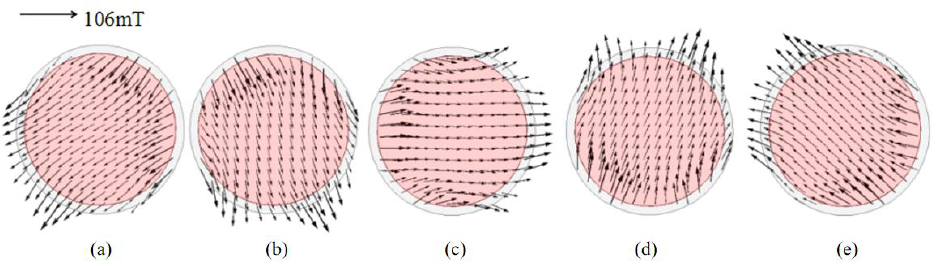
Figure 4. Magnetic flux density vectors at mid-plane of the stirrer: (a) 0, (b) 1/5 T B , (c) 2/5 T B , (d) 3/5 T B , (e) 4/5 T B .